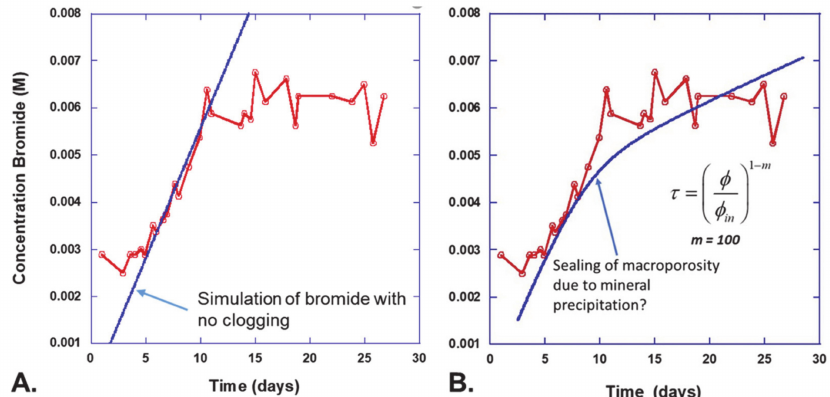
Figure 18. Time evolution of bromide concentration in low concentration distal reservoir. Red lines with circular symbols indicate experimental data. Blue line shows simulation results. ( A ) single porosity simulation without clogging, ( B ) dual porosity simulation with clogging in the bulk porosity, while diffusion can continue in the diffuse layer porosity. The system starts sealing at about 10 days, resulting in a flattening of the concentration profile.